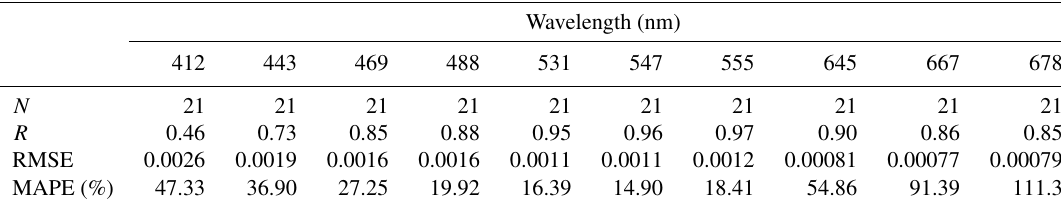
Table 2. Results of the matchup comparison of satellite R rs (λ) with in situ measurements.